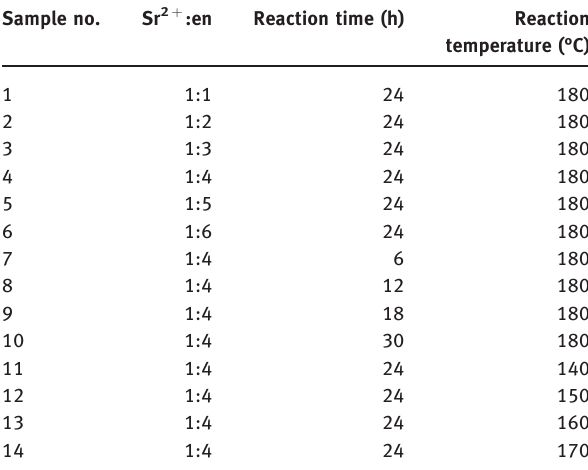
Table 1: Experimental condition of SrCO 3 formation. Sample